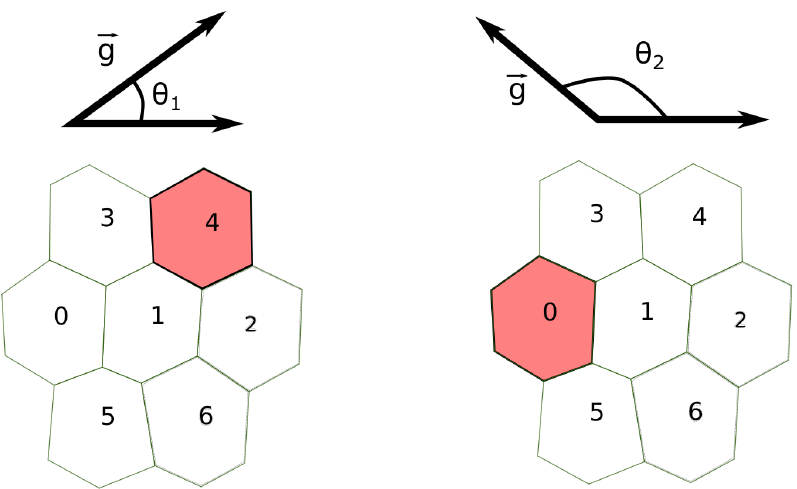
Fig 1. Computation of the SNR in a 2-dimensional LEGI model. We account for different orientations of the gradient ~ g by computing the SNR for 500 different values of the angle θ 2 [0, 2 π ]. For each value of θ , we estimate ffiffiffiffiffiffiffiffiffi p in the edge cell, namely the cell measuring the highest concentration of the signal (colored in red). In the SNR examples depicted here, for θ = θ 1 (left) and θ = θ 2 (right), the edge cells are cell 4 and cell 0, respectively.